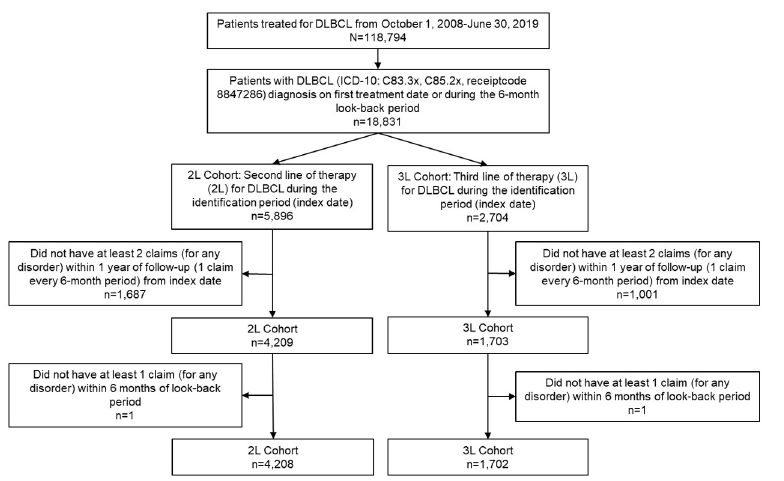
Fig 3. Selection flow for patients with rrDLBCL in each